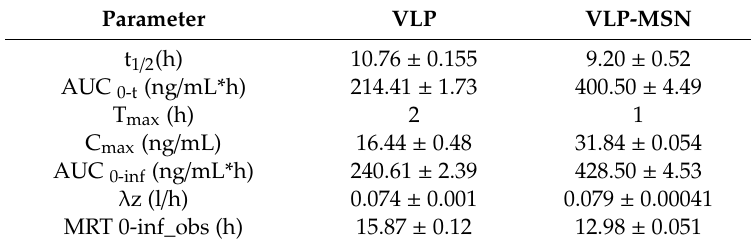
Table 1. Pharmacokinetic parameters of VLP and VLP-MSNs after single dose oral administration to